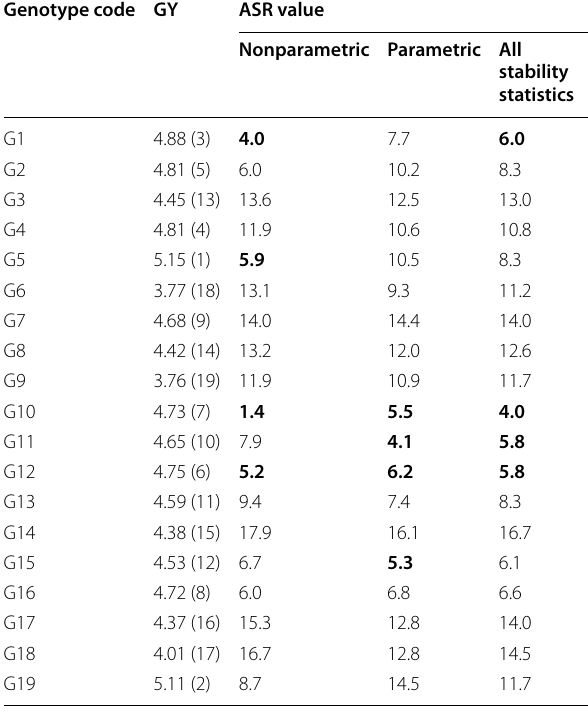
Numbers in parentheses indicate the ranking pattern of genotypes based on the mean grain yield Genotypes with the lowest ASR values have been highlighted